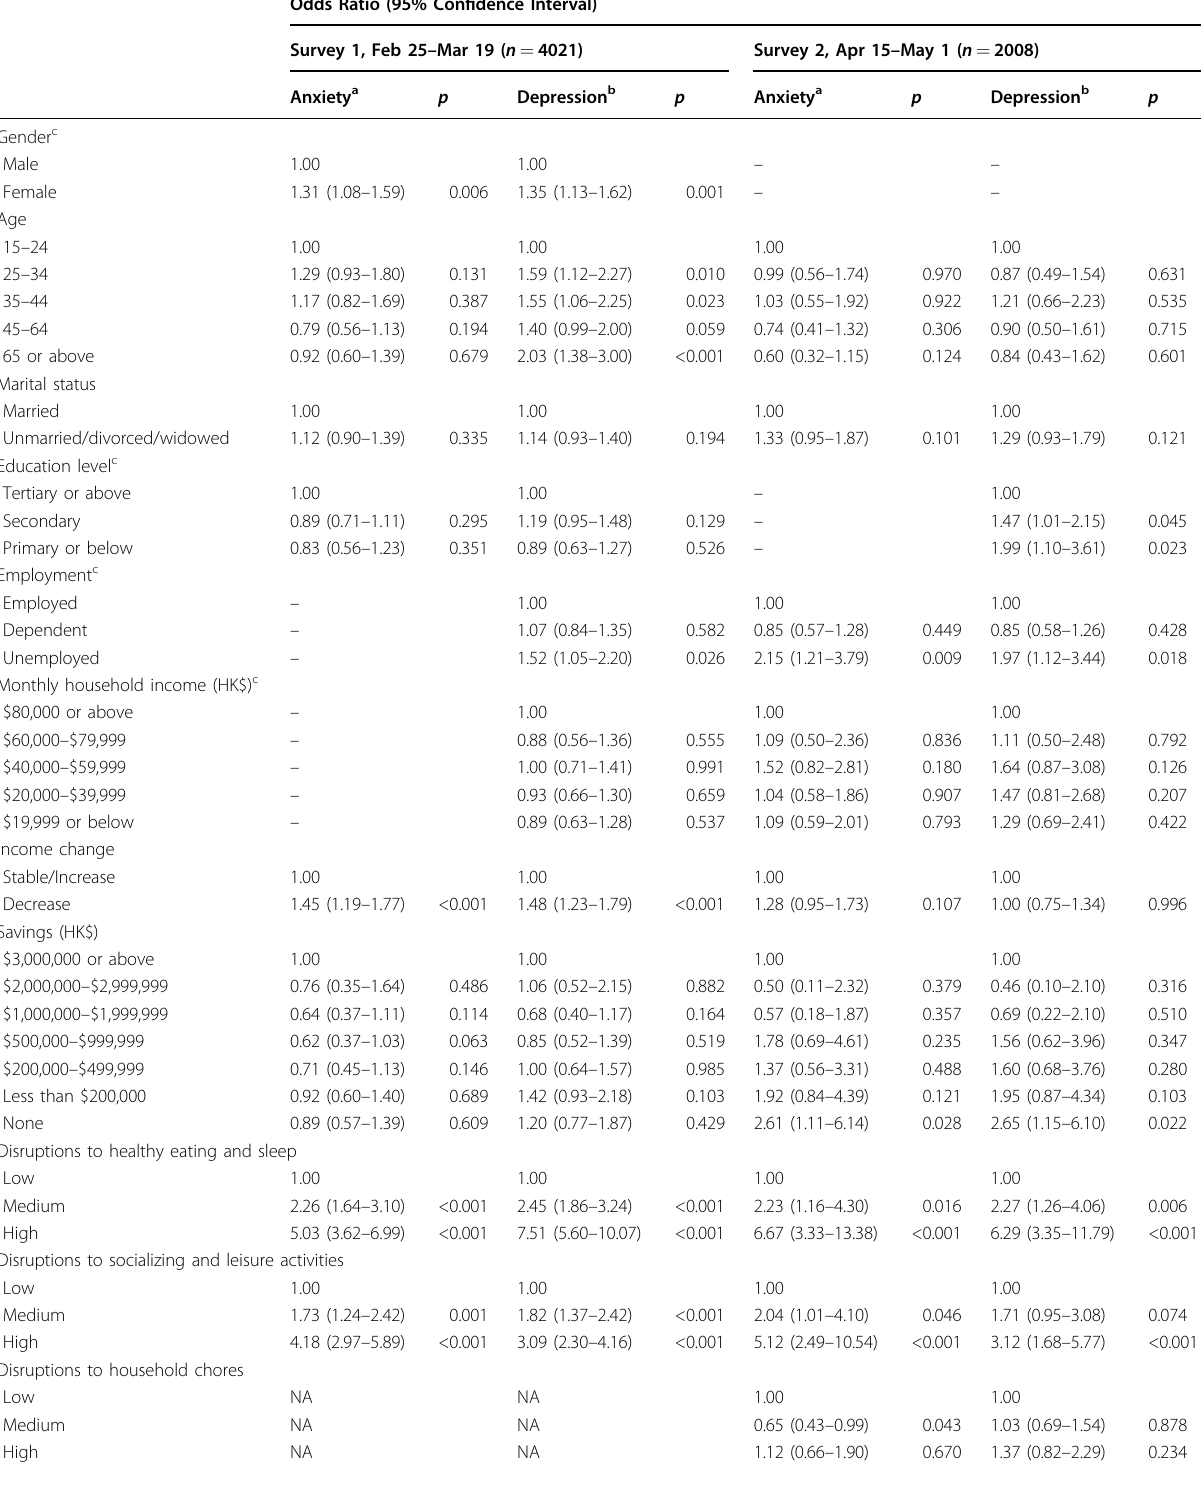
Table 2 Multivariable logistic regression examining correlates of anxiety and